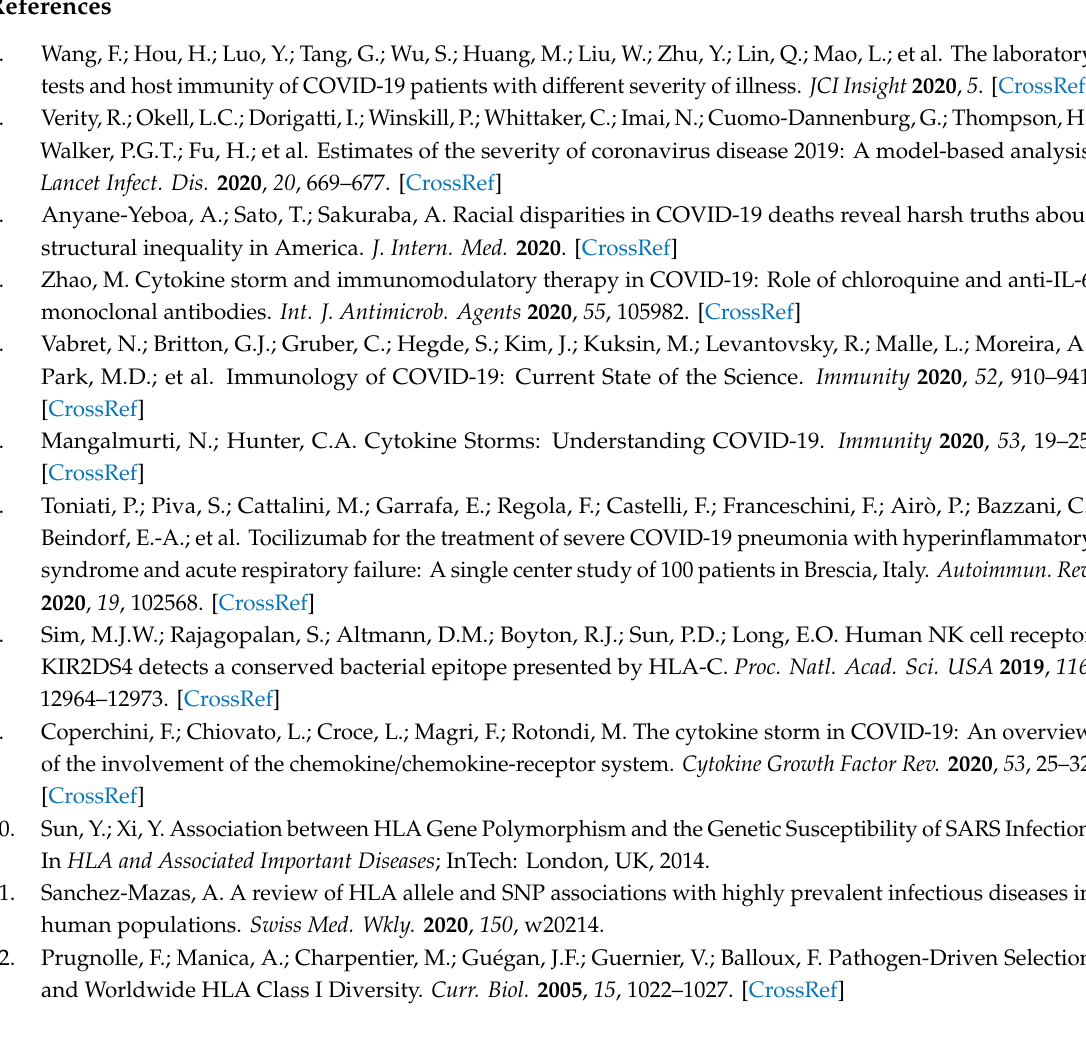
Figure S1: Allele frequencies of class I HLAs among countries in each